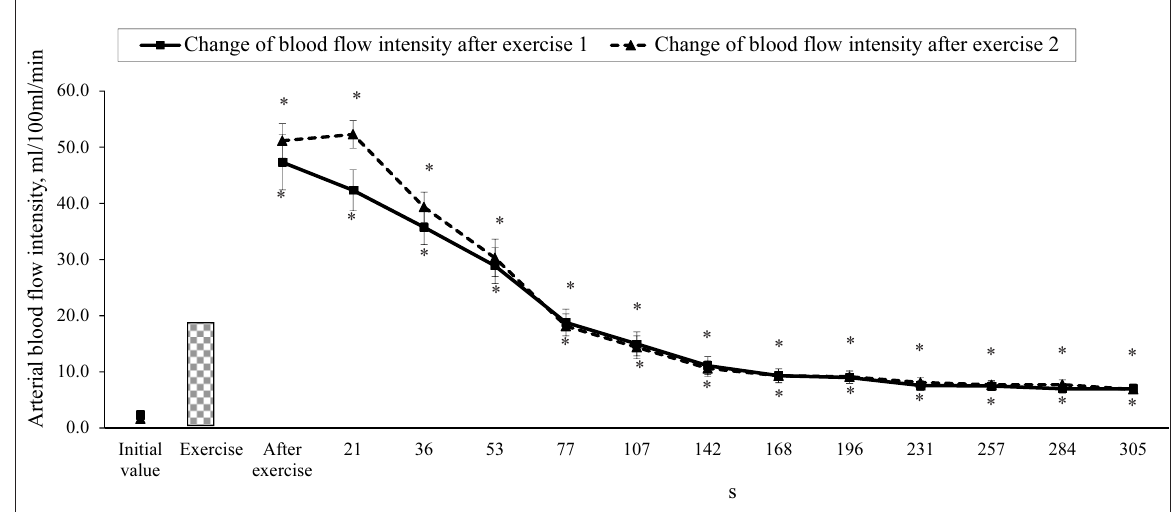
Figure 3. Changes of arterial blood flow intensity after the first and the second exercises in the control group